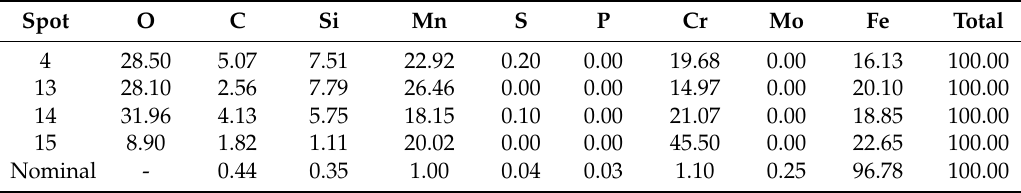
Table 5. Elemental composition distribution of the oxide particles from EDS analyses on the corresponding spots marked in Figures 8b and 9b (at %).